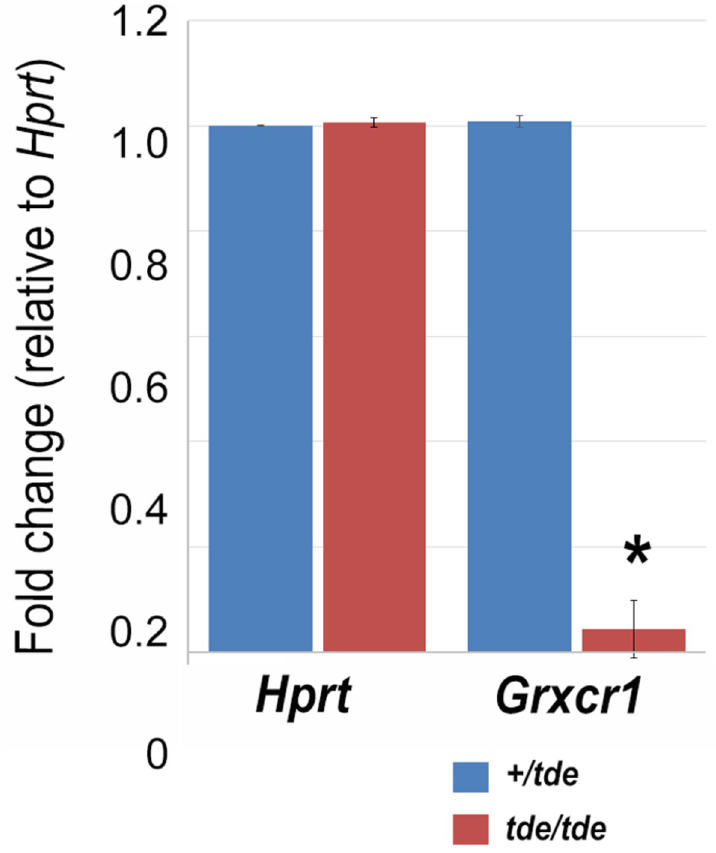
Fig 2. Grxcr1 expression analysis by qRT-PCR in the inner ear. Quantitative real-time PCR on cDNA generated from total RNA from whole inner ear at P7 (n = 11 tde/tde ; n = 5 +/ tde ). Grxcr1 normalized to Hprt levels was significantly down-regulated in tde/tde mice (red bars) compared to controls (blue bars) ( � P < 0.001, Wilcoxon rank sum test). Error bars indicate standard deviations. splice sites, using genomic DNA from phenotyped adults (n = 1 +/+ (C57BL/6N); n = 12 +/tde ; n = 16 tde / tde mice). Exons were sequenced by capillary sequencing and traces were analysed. No changes were found in the coding sequence of any exon of the Grxcr1 gene in the homozygous mutants compared to wild-type C57BL/6N and +/tde mice (Fig 3A). PCR ampli- fication of total cDNA from adult inner ears and brains using primers located within Grxcr1 exons 1 and 4 showed that two bands of different size were amplified in both mutant and con- trol samples (Fig 3B and 3C). To find out whether the two amplified bands corresponded to two different transcripts, we performed 5’ RACE-PCR (PCR for rapid amplification of cDNA ends) from inner ear samples of C57BL/6N wild-type mice at P0 and P6, using a primer in the 3’UTR for the initial reverse transcription. The sequencing of the two amplified bands revealed that the larger band contained all four exons whereas the smaller band skipped exon 2 and is therefore a novel transcript (Fig 3D and 3E; S1 File). This smaller, novel transcript, which we observed in cDNA made using a poly-d(T) primer as well as in the 5’RACE, had clearly under- gone intron excision, so we conclude that it is likely to represent the mature mRNA sequence. Therefore, our results show the presence of two different transcripts of Grxcr1 , which are iden- tical in control and tde/tde inner ears. Exon 2 has 243 base pairs and starts and ends in phase 0, so its absence does not change the amino acid sequences of exons 1, 3 or 4, but the resulting